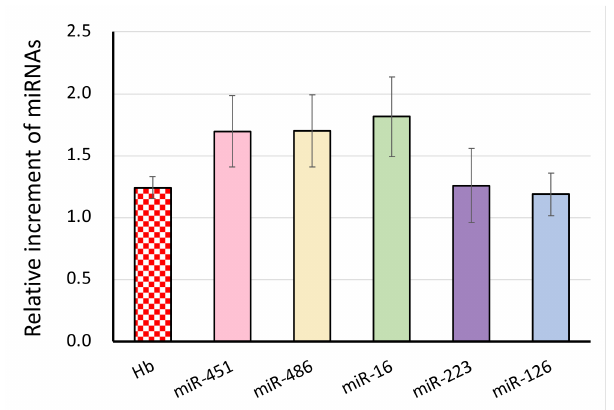
Figure 2. Relative increments of miRNAs after ex vivo blood drawing. The Hb level was measured using 414 nm OD. miRNAs were assayed with the RT-qPCR method. Each value (average ± SEM, n = 8) shows fold increments of miRNAs after blood drawing from the first blood